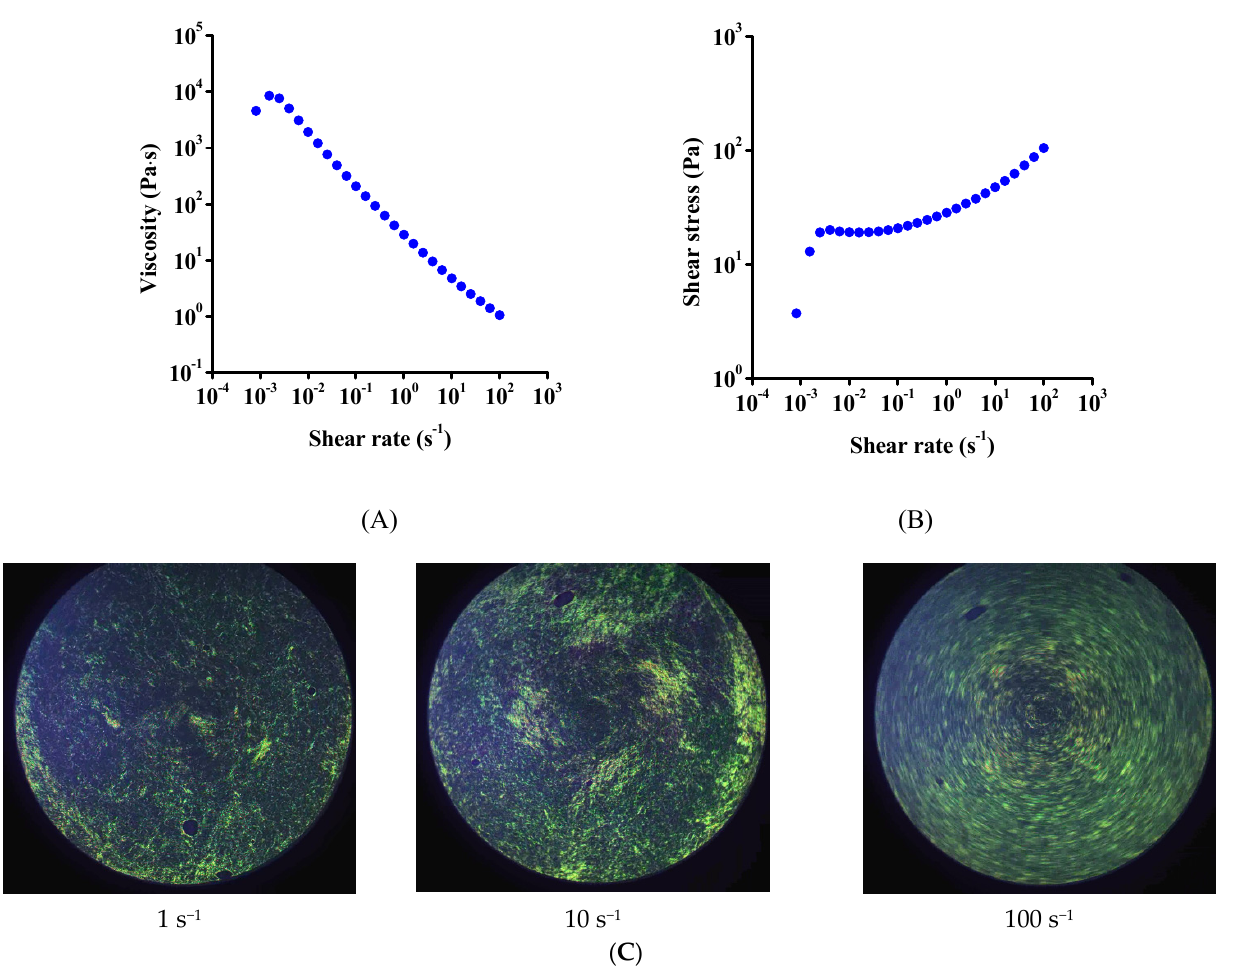
Figure 2. Steady shear measurements of fresh suspensions. Effect of shear rate on viscosity ( A ) and shear stress ( B ). Measurements were performed in triplicate using fresh samples in each case. The complete datasets are shown in Figure S1. In situ polarized light images of GO suspensions at different shear rates ( C ).